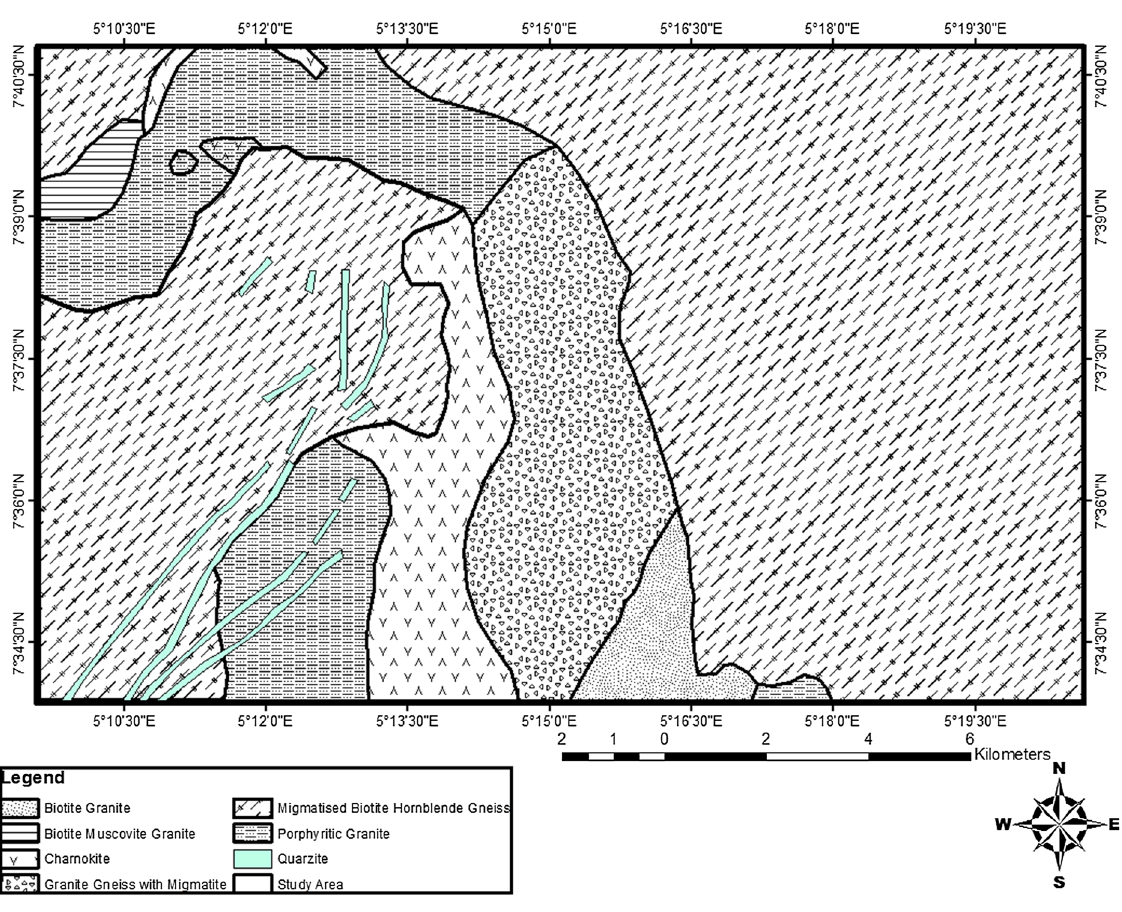
Fig. 3 Geological map of Ado-Ekiti. After NGSA; Geological map of Akure Sheet 56, 1966 Fig. 4 The processing flow